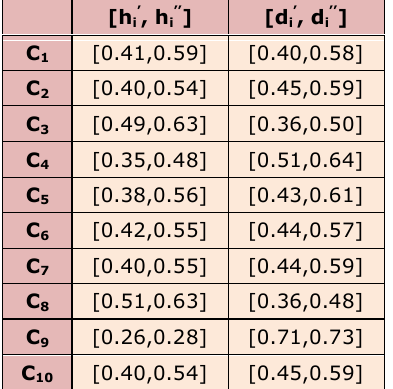
Table 5. The values of h i ’ , h i ’’ , d i ’ and d i